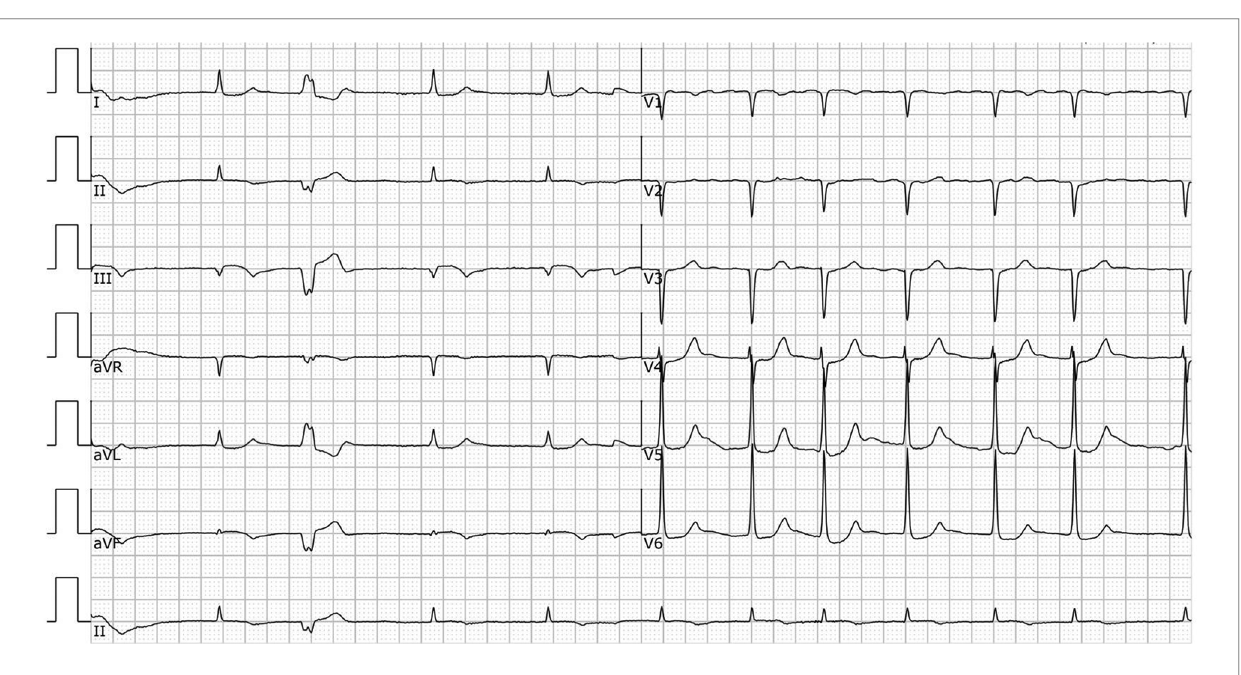
FIGURE 6 ECG after the procedure. ECG showing AF, and premature ventricular